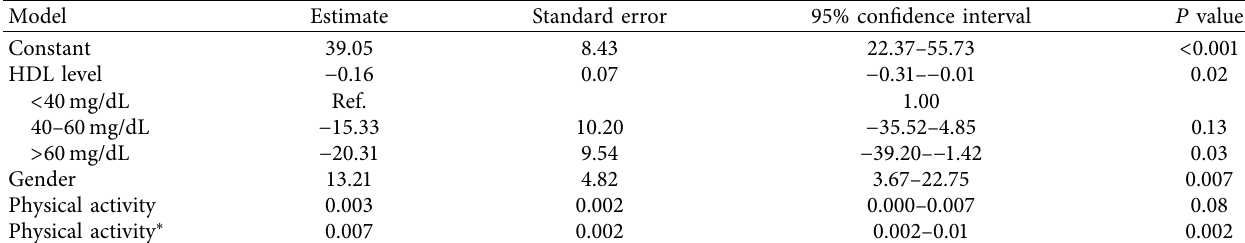
Table 5: Determinants of HRQOL.